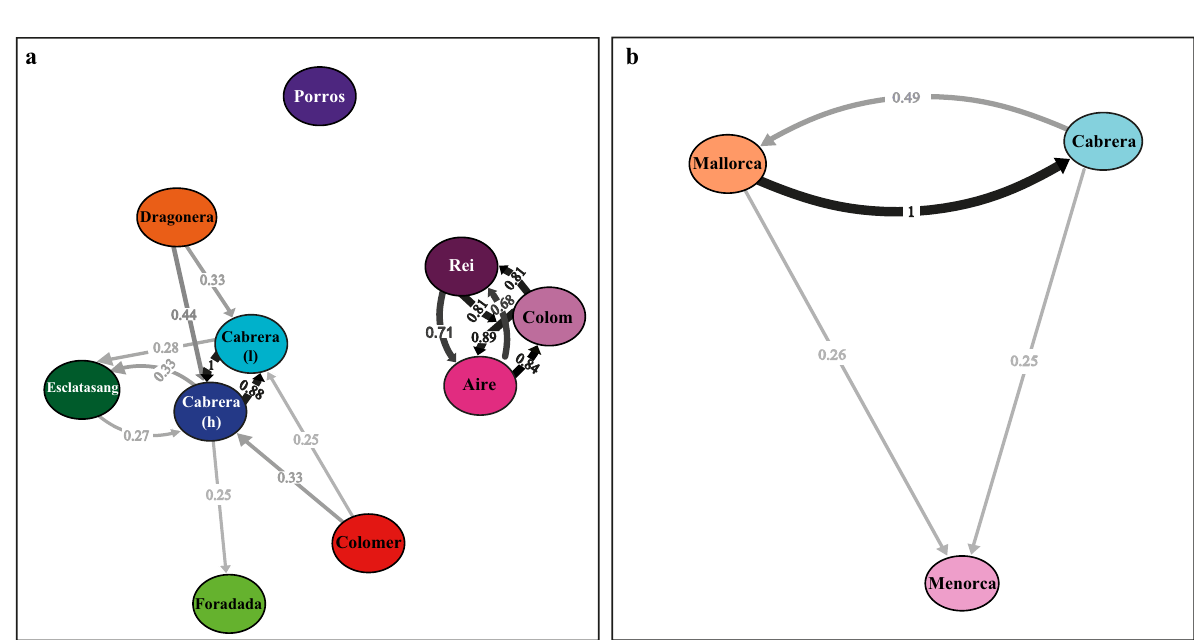
Figure 4. Migration networks for the Podarcis lilfordi based on all SNPs (72,846) among the 10 populations ( a ) and between the three main islands (Menorca, Mallorca, Cabrera) ( b ), obtained with the Nei’s G ST estimate using divMigrate. Only migration rates ≥ 0.25 are indicated, circles represent the localities, and arrows indicate the direction of